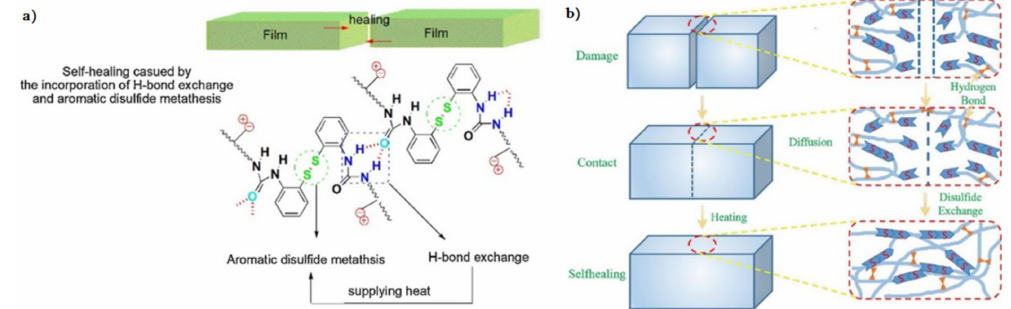
Reproduced from [191] with permission from Elsevier. ( b ) Schematic representation of the self-healing